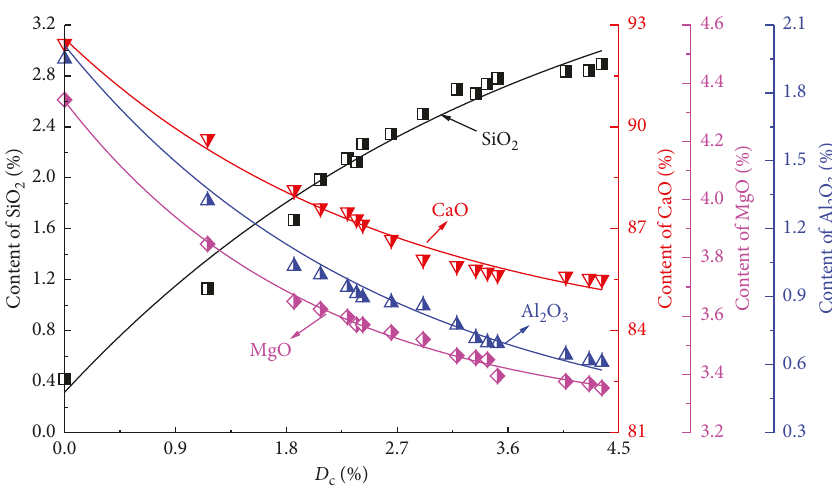
Figure 14: Variations in mineral contents of marbles versus damage